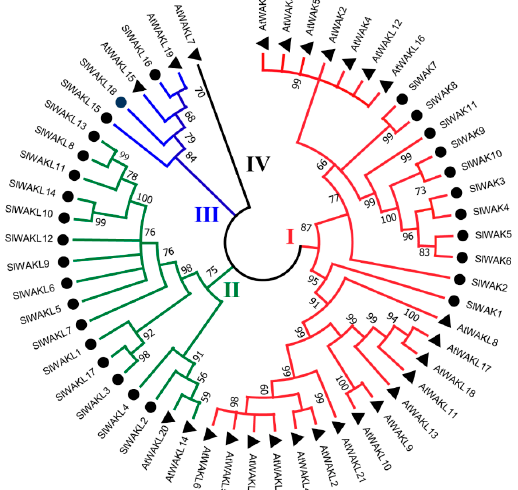
Figure 3. Phylogenetic analysis of WAK-RLKs. The phylogenetic tree was generated using the amino acid sequences of selected WAK-RLKs via NJ methods. All tomato WAK-RLKs, together with theirArabidopsis thaliana homologues were classified into 4 groups. At represented A. thaliana .